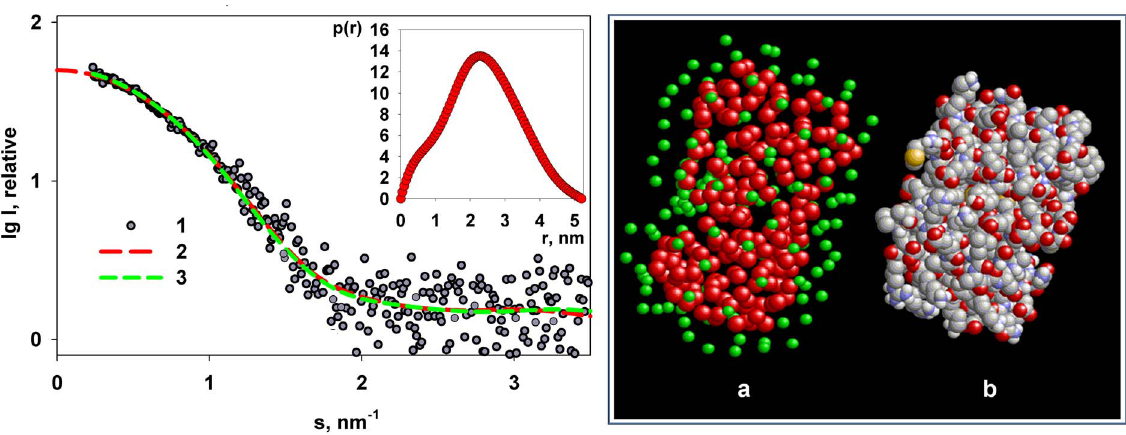
Figure 6. Shape restoration of the NM-domain. Left panel: experimental SAXS data (1), the transformed from p(r) and extrapolated to zero scattering angle intensity (2), scattering pattern computed from the GASBOR model (3). Insert: distance distribution function p(r) computed by GNOM. Right panel: the model reconstructed by GASBOR (red balls, dummy residues, green balls: dummy water molecules) (a), crystal structure of the NM-domain (PDB code 1AA7) (b).